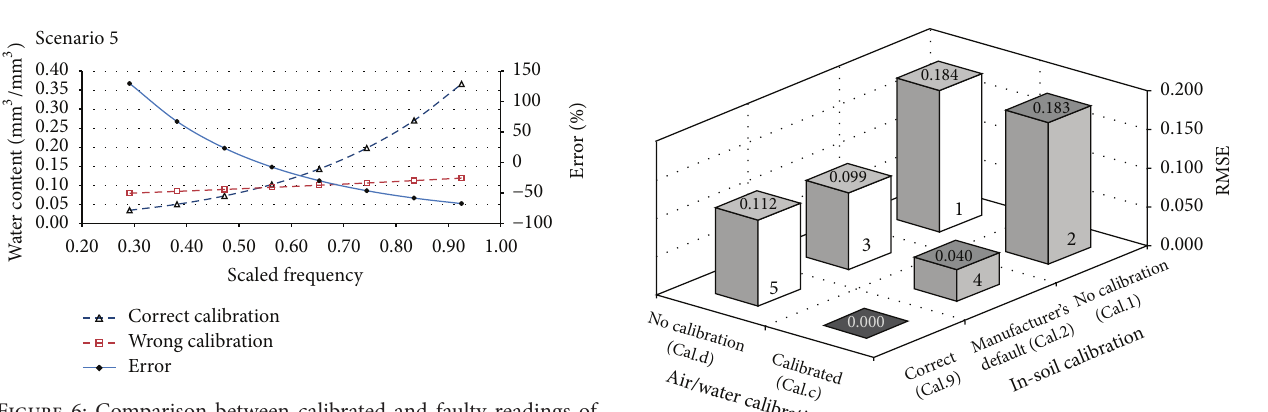
Figure 6: Comparison between calibrated and faulty readings of EnviroSCAN probe for Scenario 5.